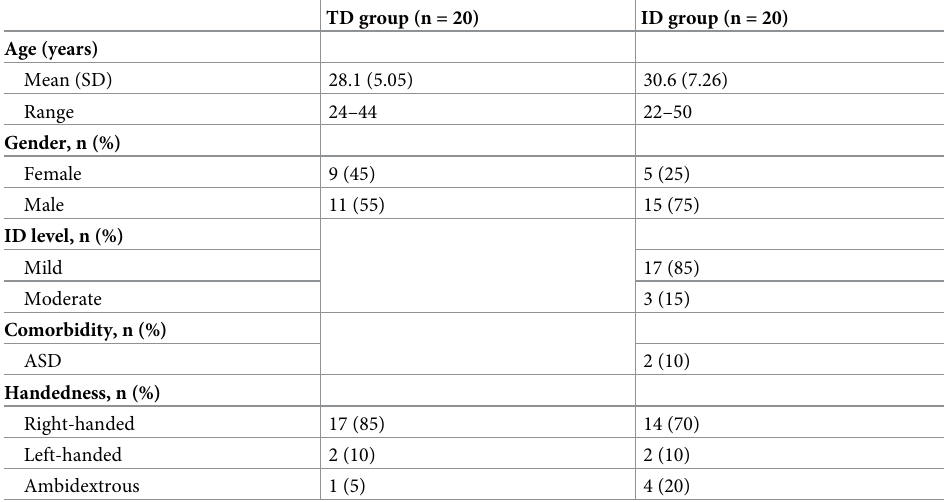
Table 1. Characteristics of participants in the TD and ID